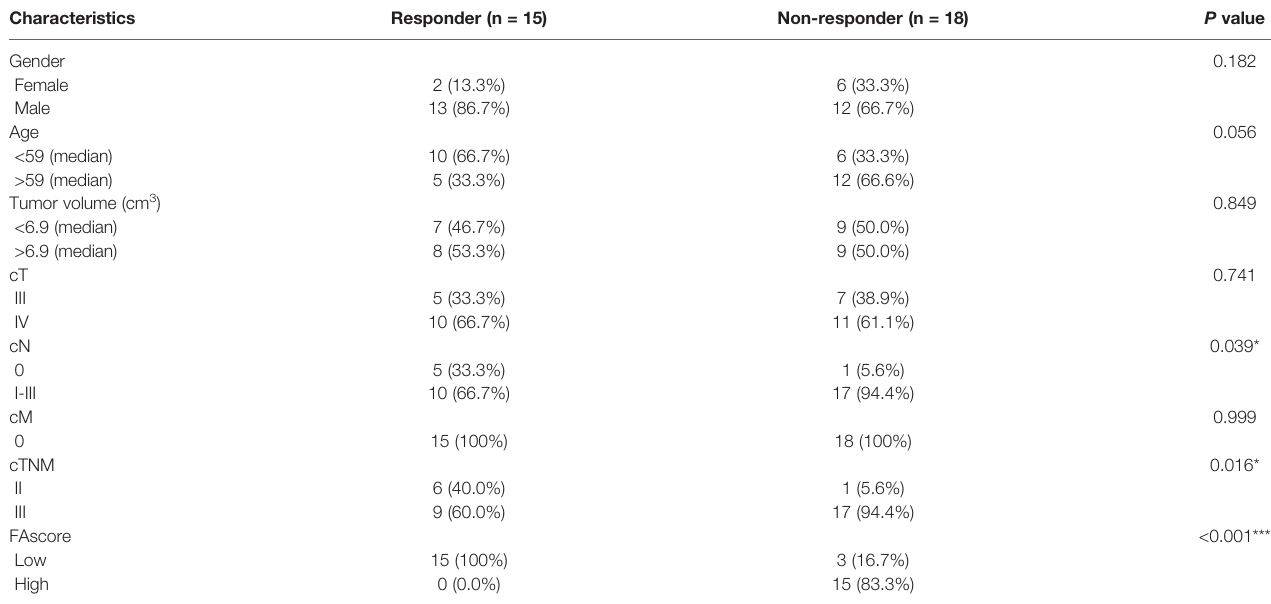
TABLE 1 | Analyses of relative factors for treatment response to chemotherapy in patients with gastric cancer.